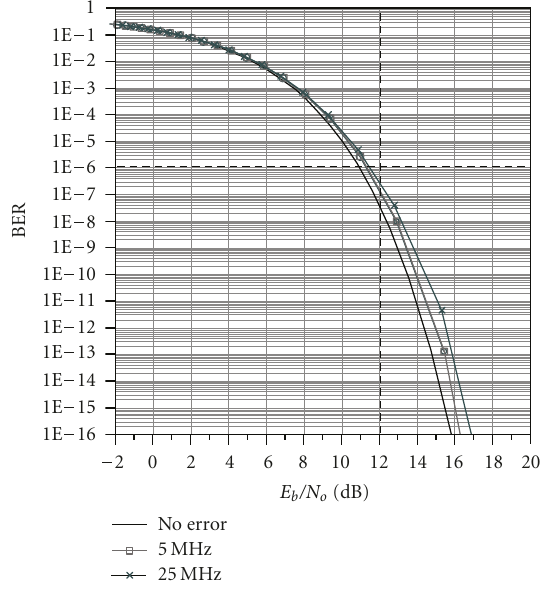
Figure 17: BER simulation results for various errors of synchro- nism of the millimeter-wave